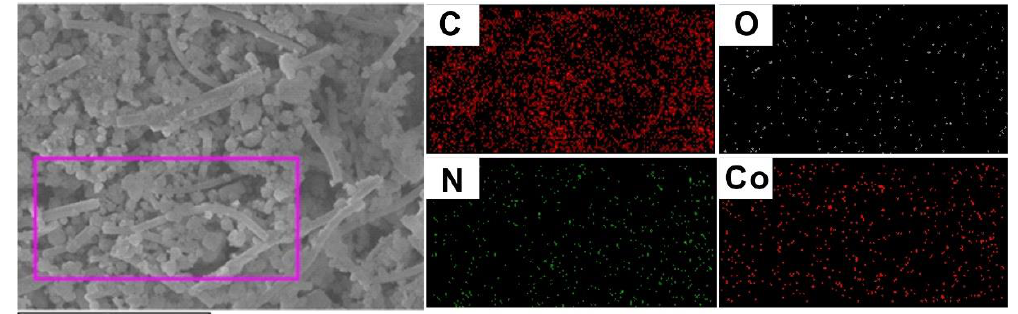
Figure 2. Element mapping images of the ZIF-67/CNFs composite.